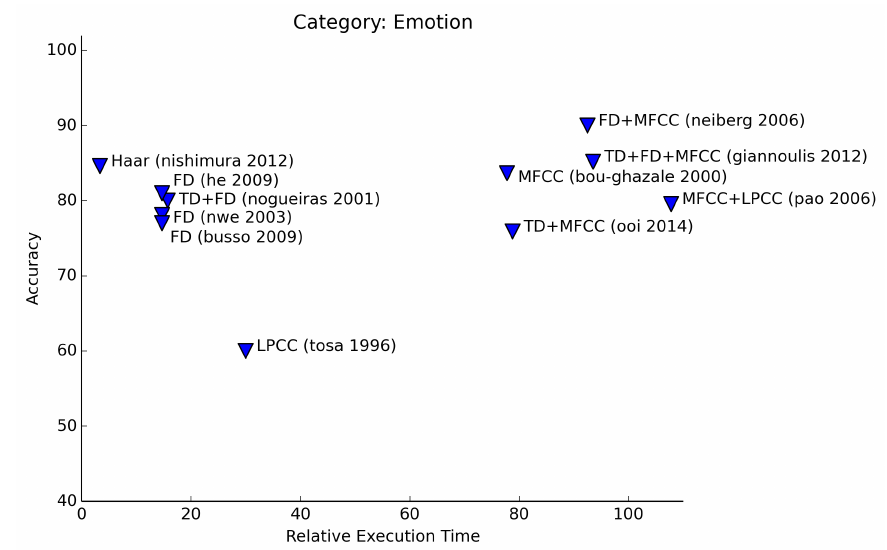
Figure 10. Relative execution time for emotion